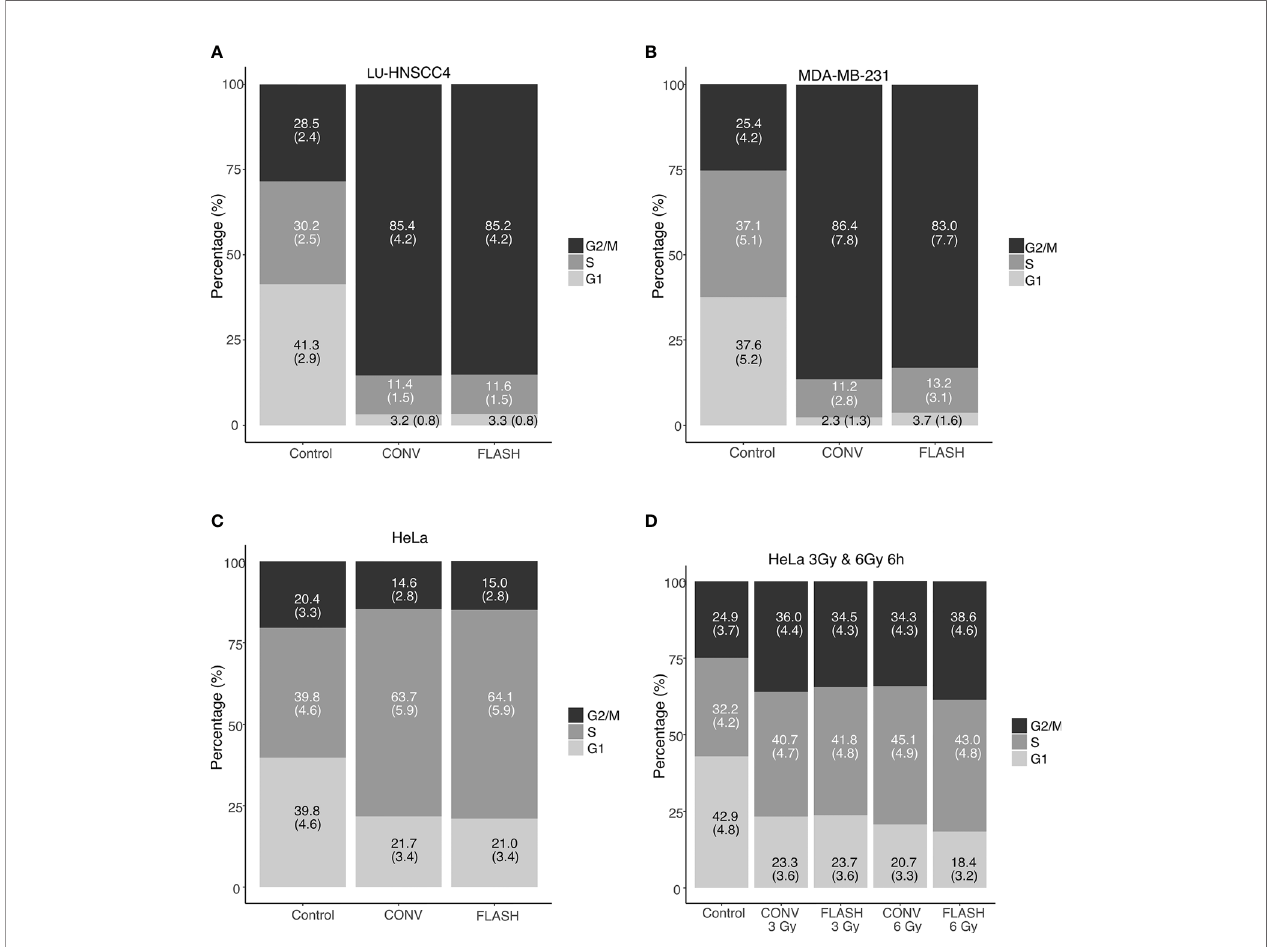
FIGURE 3 | Cell cycle distributions determined by fl ow cytometry after irradiation with FLASH or conventional dose rate (CONV). In (A – C) , cell cycle distribution 24 h after irradiation with 6 Gy for LU-HNSCC4 (A) , MDA-MB-231 (B) and HeLa subclone (C) . In (D) an earlier time-point (6 h) after irradiation with 3 Gy and 6 Gy using the HeLa subclone . Bars illustrate G1 (light grey), S-phase (grey), and G2/M (black). The fi gures in the bars denote the percentage of cells (with standard deviations). Data from two independent